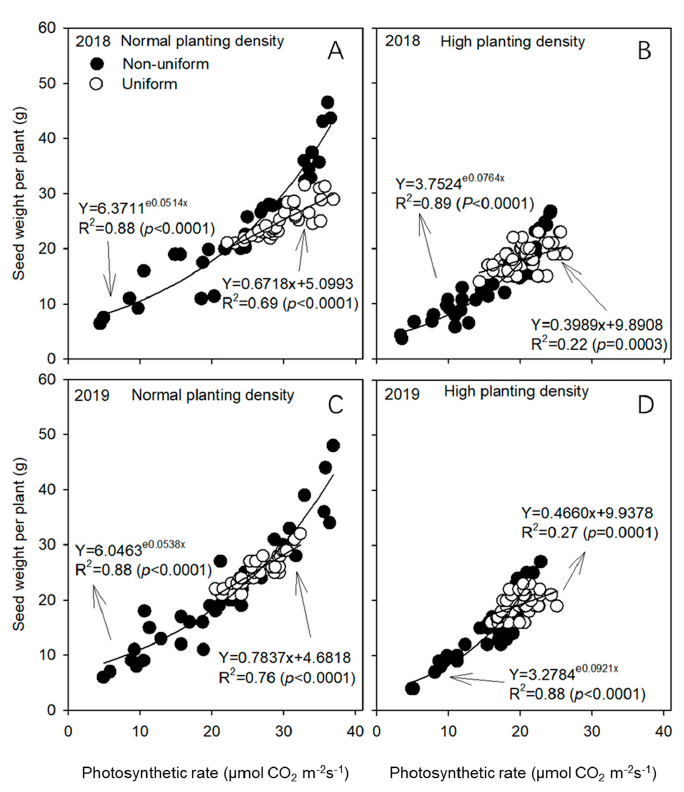
Figure 9. The relationship between seed weight per plant and photosynthetic rate of soybean under normal planting density in 2018 ( A ) and 2019 ( C ) and under high planting density in 2018 ( B ) and 2019 ( D ).